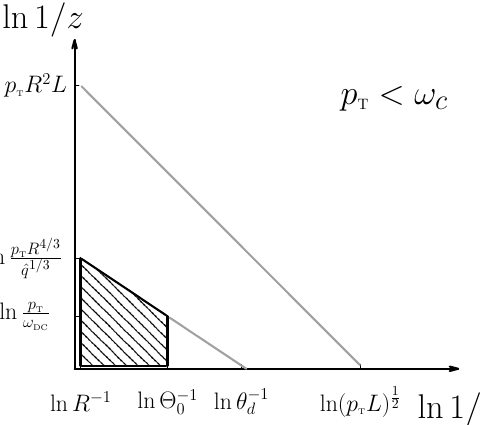
Fig. 1 Illustration of the DLA phase space for higher-order quench- ing effects for massive particles, marked by the black, lined area. The two lines correspond to t f = L (upper line with slope − 2) and t f = t d